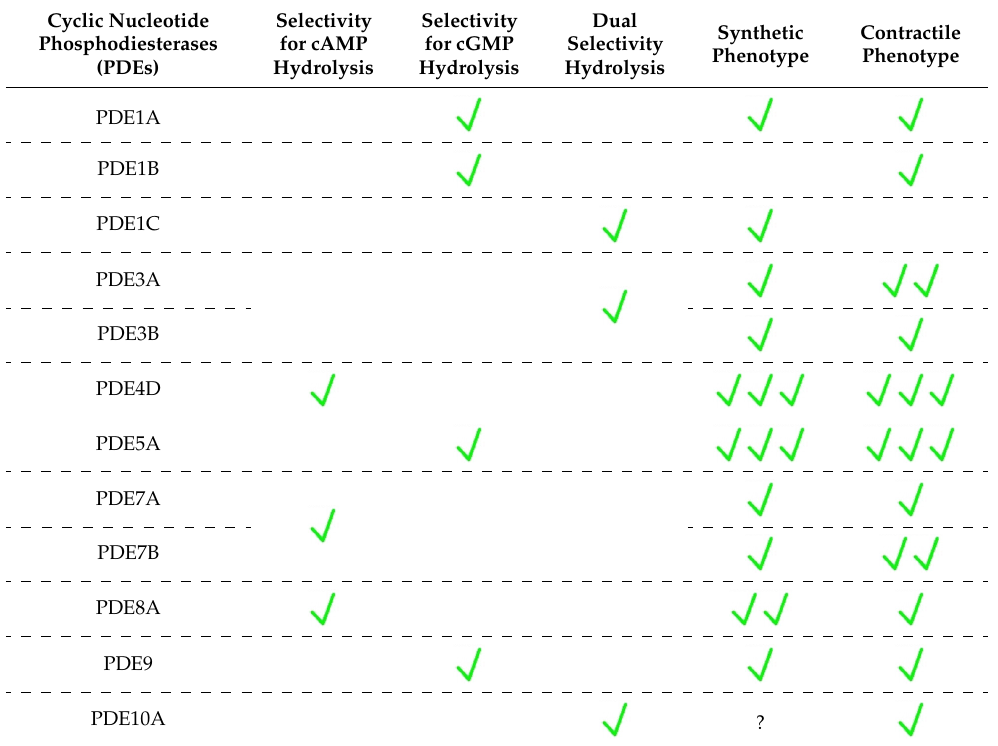
Table 1. PDEs expressed in vascular smooth muscle and their expression according to SMCs phenotype. Cyclic Nucleotide Selectivity Selectivity Phosphodiesterases for cAMP for cGMP (PDEs) Hydrolysis